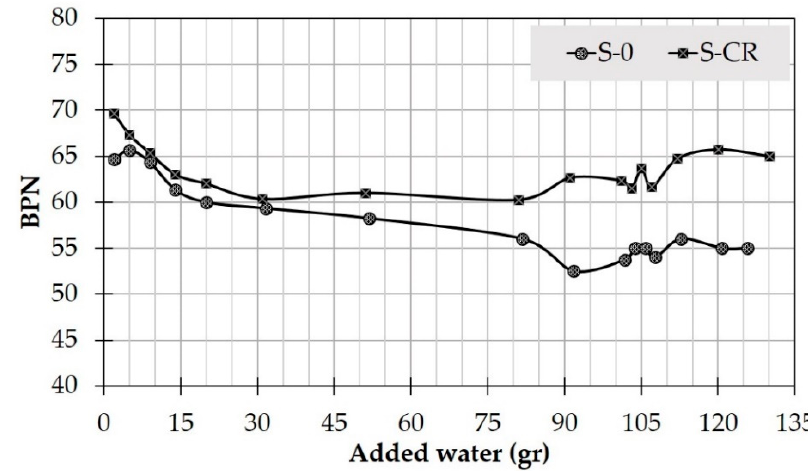
Figure 14. BPN levels during phase (5)—“water addition up to cleaning” for S-0 and S-CR specimens.